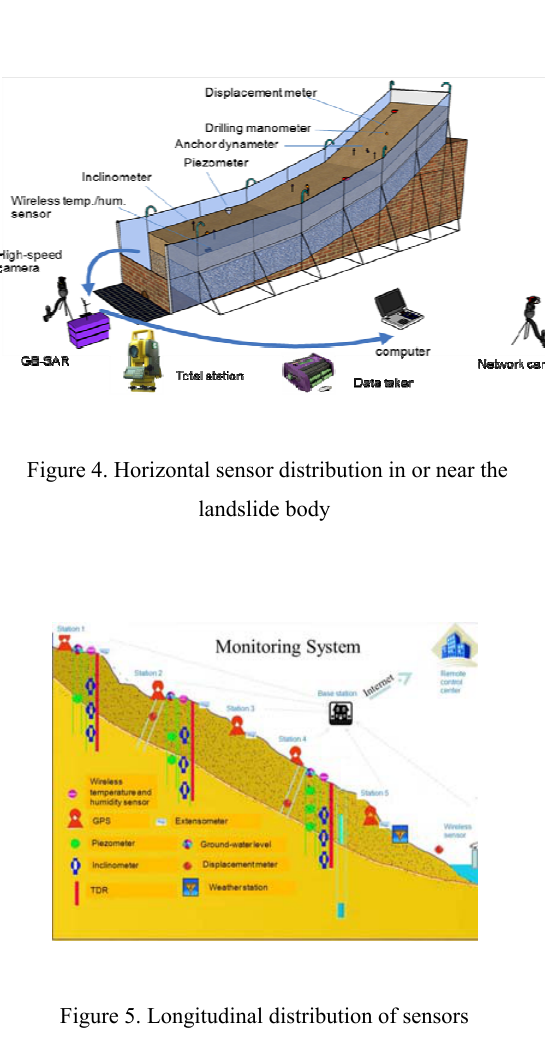
In detail, the layout of this spatial sensor network aims at 5 observation factors. First, it provides a real-time monitoring of displacements. This is fulfilled through displacement meter measuring displacement along the landslide surface